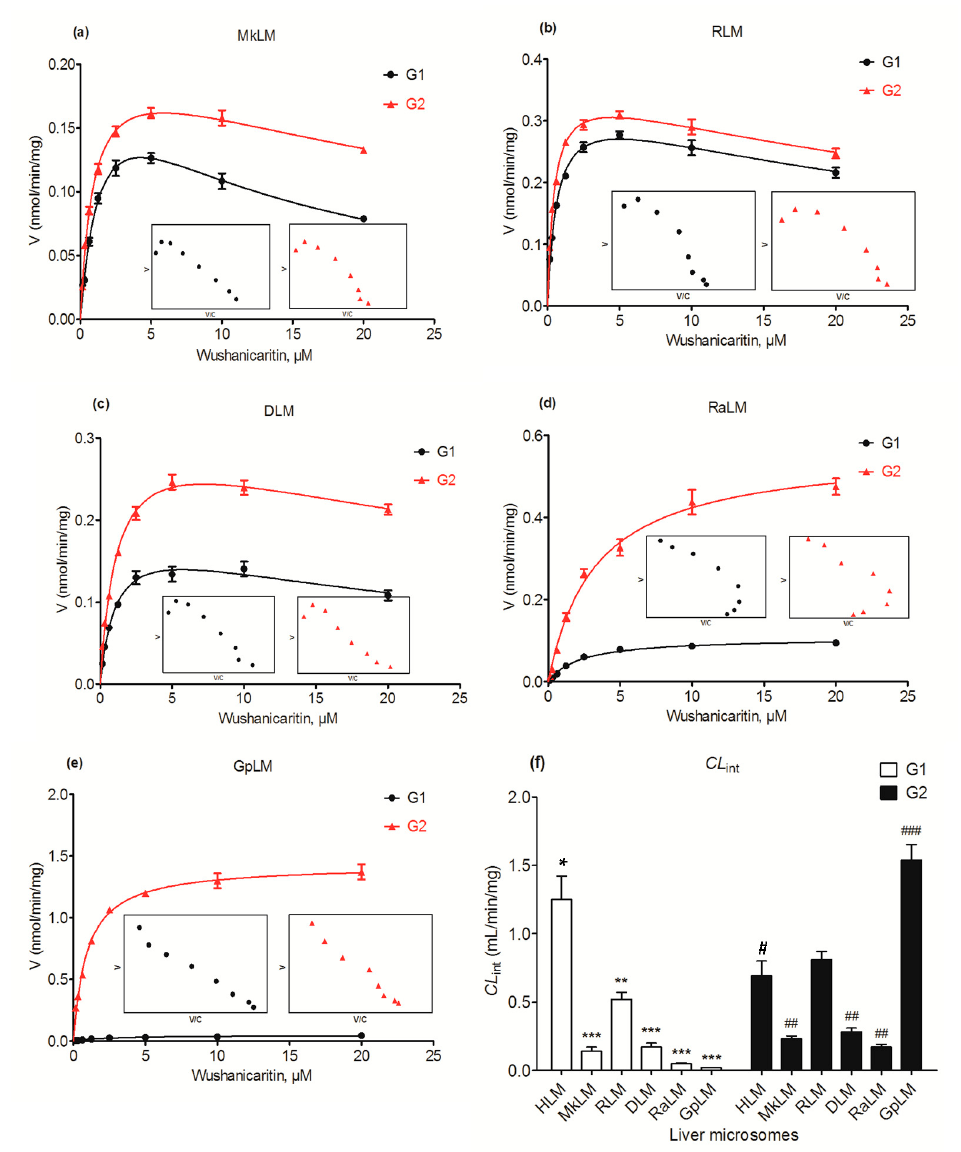
Figure 6. Kinetic profiles for the glucuronidation of wushanicaritin by various types of animal microsomes. ( a ) monkey liver microsomes (MkLM); ( b ) rat liver microsomes (RLM); ( c ) dog liver microsomes (DLM); ( d ) rabbit liver microsomes (RaLM); ( e ) guinea pig liver microsomes (GpLM); and the intrinsic clearance ( CL int ) values of human liver microsomes and five animals microsomes ( f ). In each panel, the insert figure shows the corresponding Eadie–Hofstee plot. All experiments were performed in triplicate. Data are expressed as the mean ± SD. HLM: human liver microsomes; G1: wushanicaritin-3- O -glucuronide; G2: wushanicaritin-7- O -glucuronide. * compared with the CL int value of G1 in HLM, * p < 0.05, ** p < 0.01, *** p < 0.001; # compared with the CL int value of G2 in HLM, # p < 0.05, ## p < 0.01, ### p < 0.001.